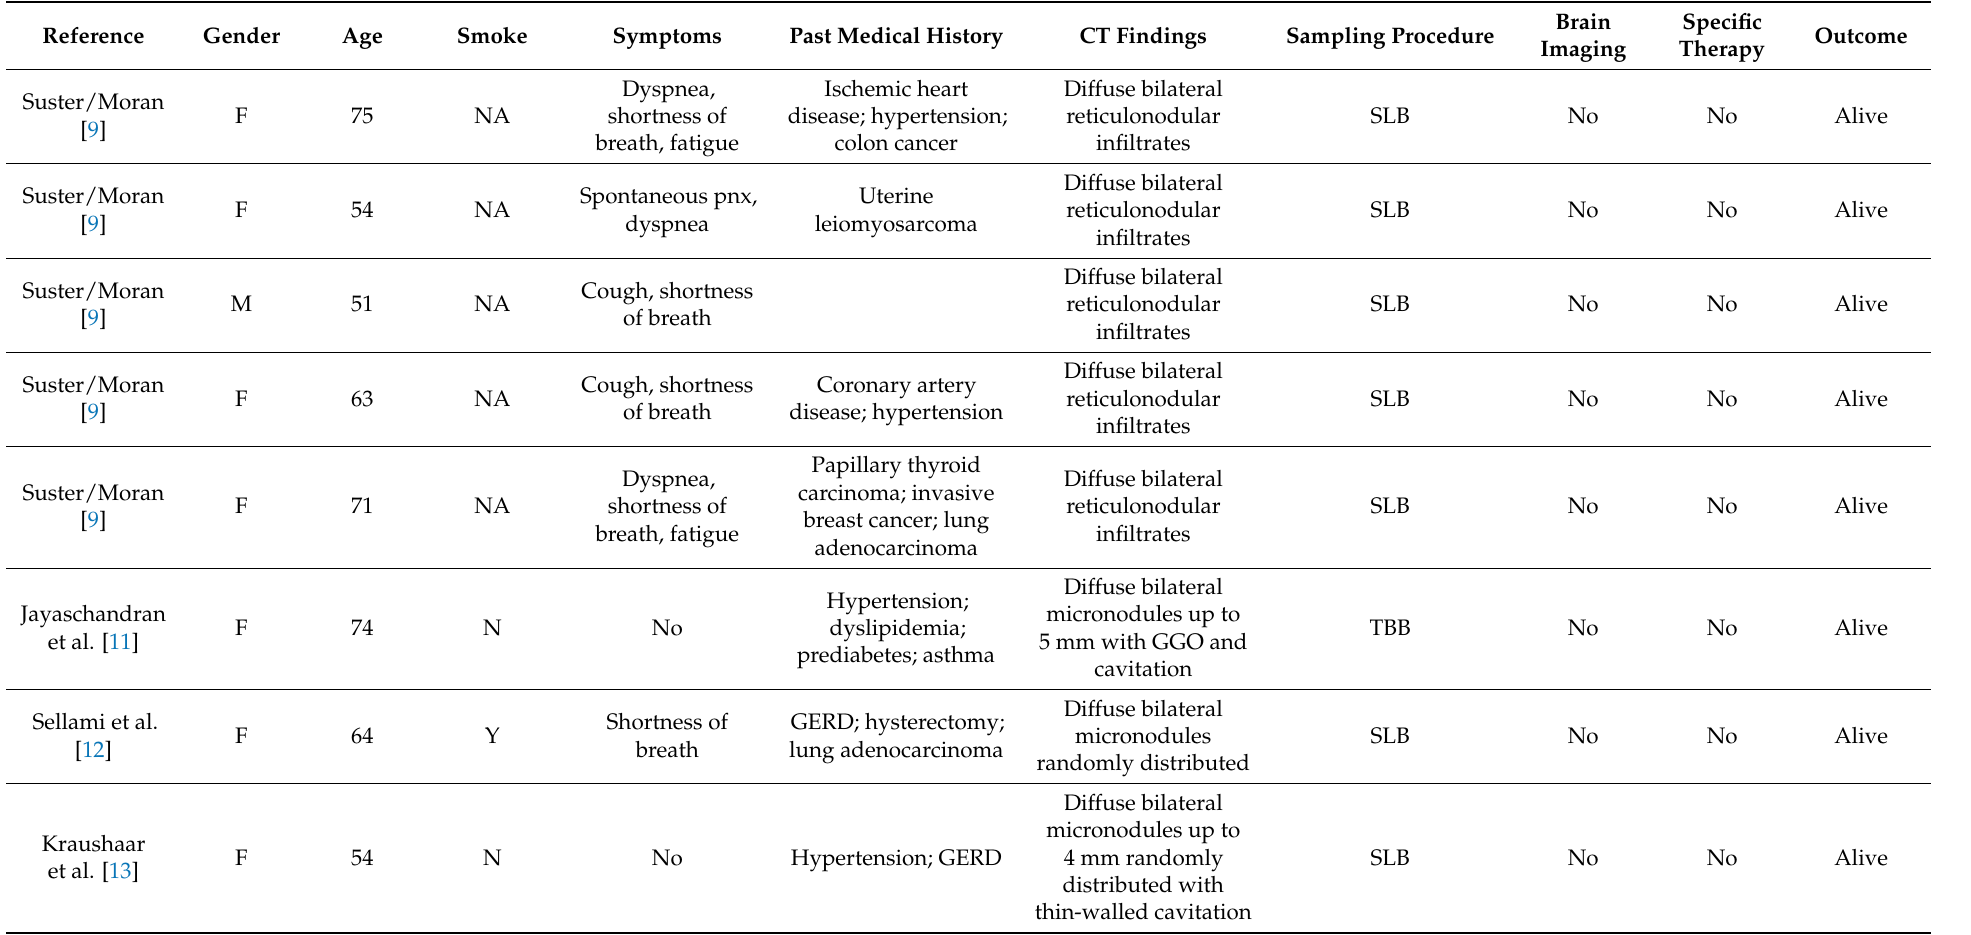
Table 2. Summary of the main clinical features of diffuse pulmonary meningotheliomatosis with clinic–radiologic details reported in the